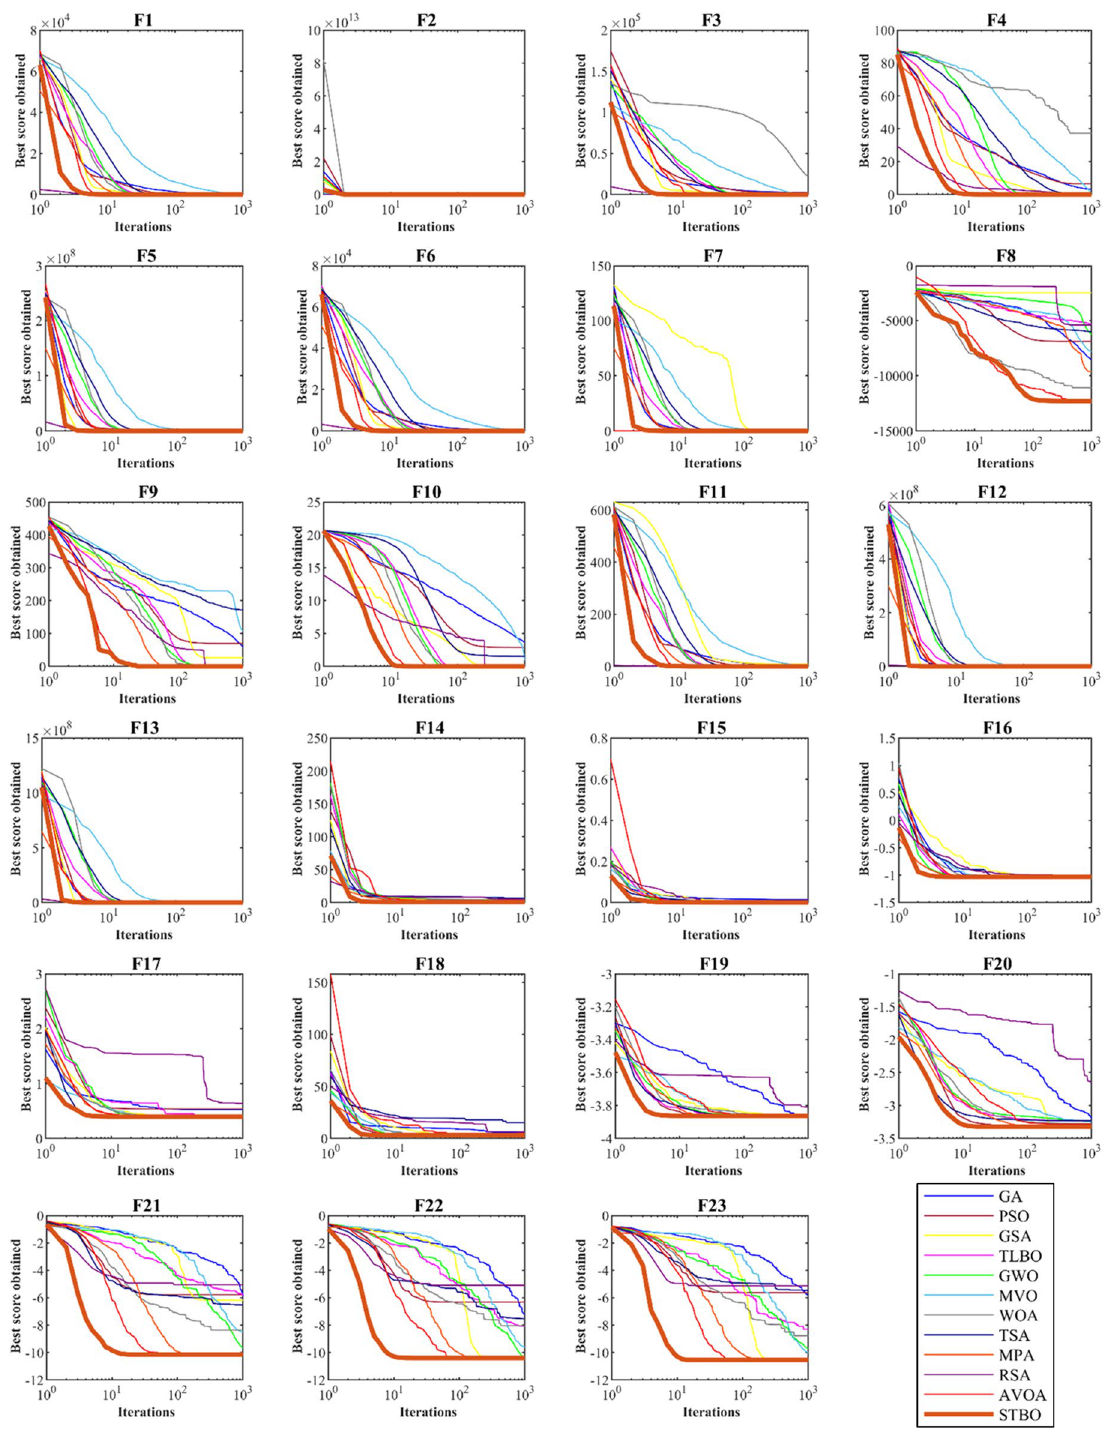
Figure 2. Convergence curves of STBO and competitor algorithms in solving F1 to